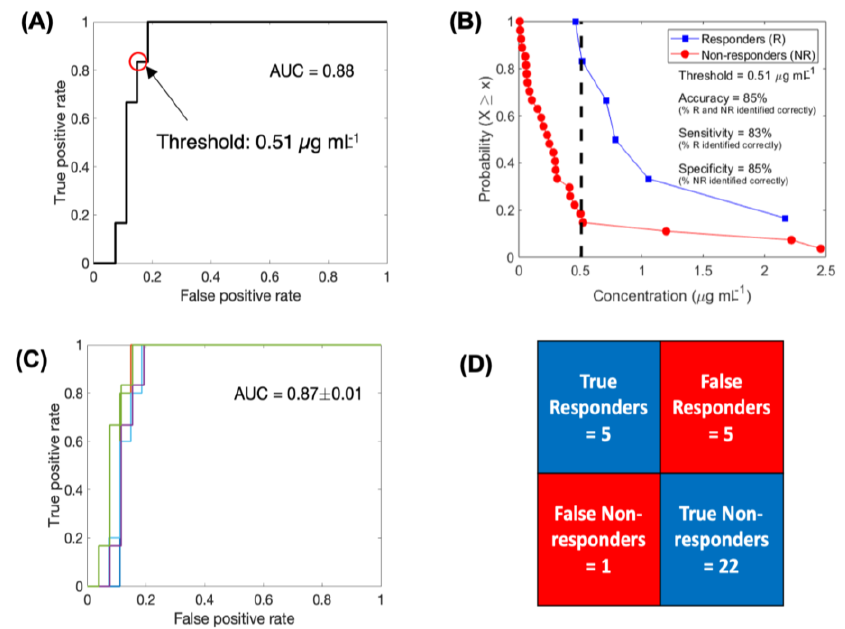
Figure 5. Logistic regression-based binary classification and cross-validation. Receiver operating characteristic (ROC) curve to evaluate the classification ability of eTSCC into responders and non- responders ( A ). Complementary cumulative distribution function (CCD) of patients shows the accuracy of binary classification at a discrimination threshold of 0.51 µ g mL − 1 ( B ). ROC curves gen- erated for multiple training data sets obtained through the leave-one-out cross validation technique ( C ). Results of cross validation in correctly classifying the test data point ( D